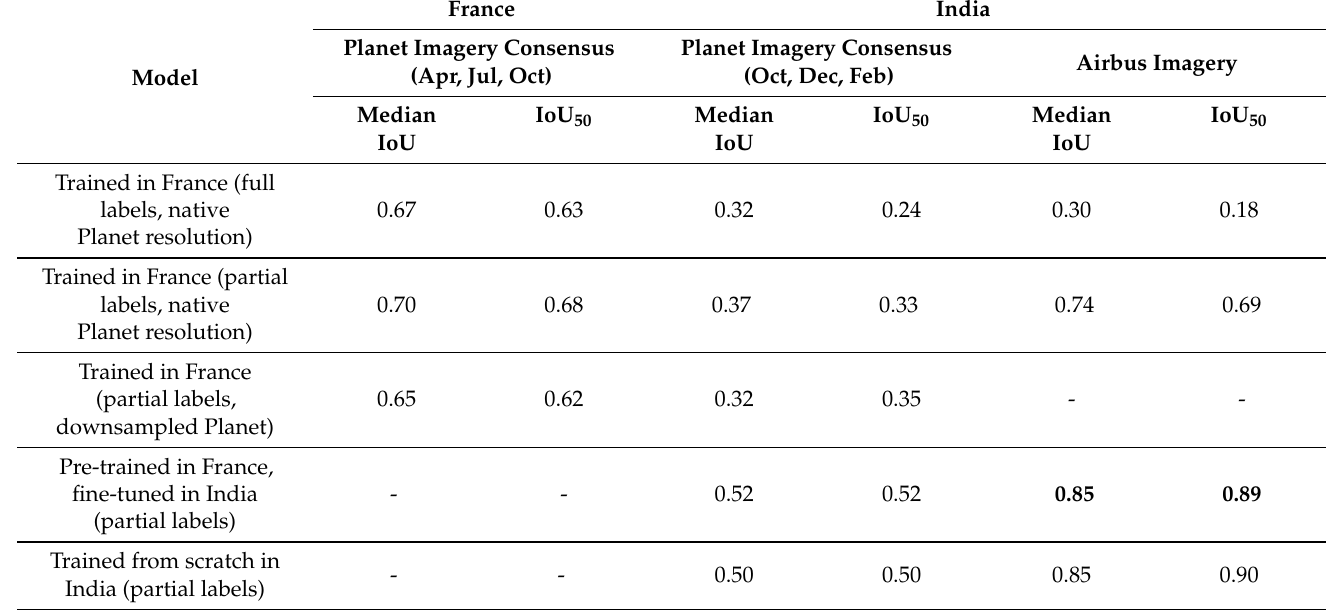
Table 4. Instance-level assessment of field delineation in France and India. Table columns show results using a 3-month Planet image consensus in France and results using both the Planet consensus and Airbus imagery in India. Each row varies the amount of knowledge transfer from France and degree of additional training in India. The reported metrics are median Intersection over Union (IoU) and the fraction of fields with IoU over 50% (IoU 50 ). The performance of the best model is highlighted in